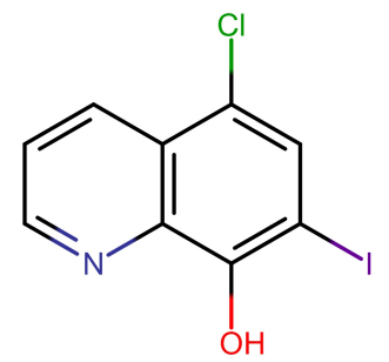
Figure 1. Chemical structure of clioquinol (CQ).